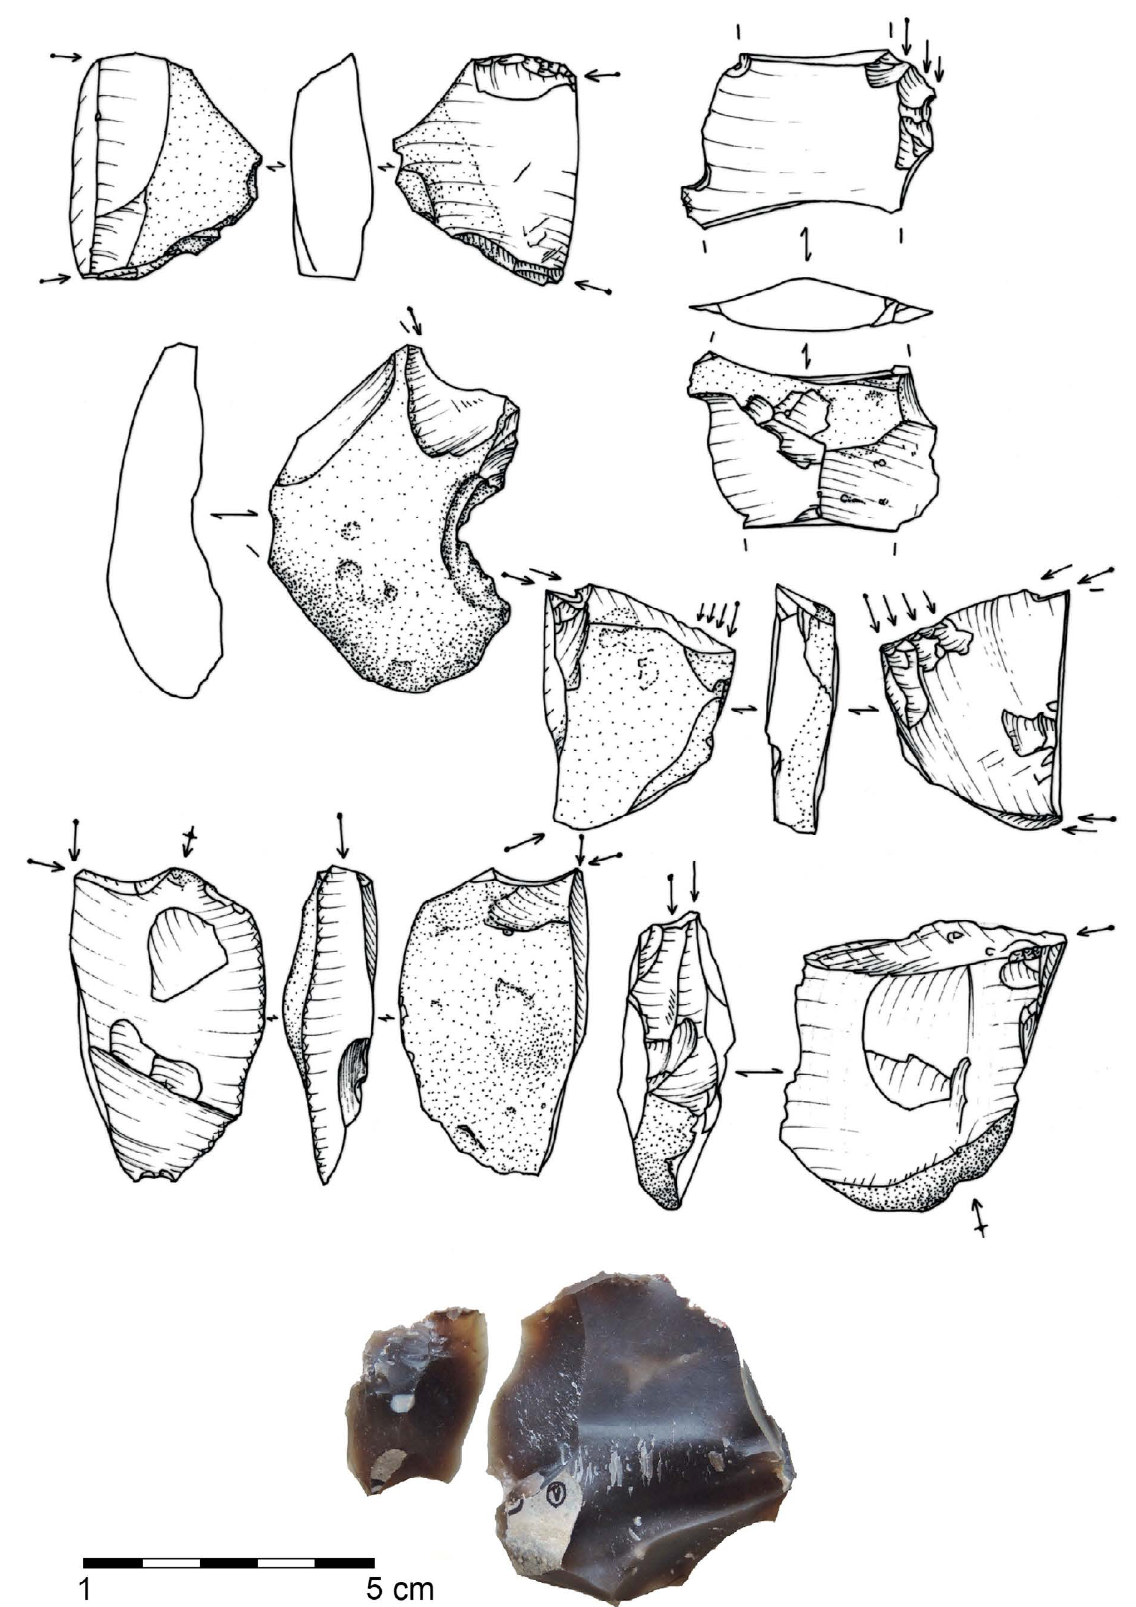
Figure 10. Burin décalé du site de d’Aubevoye « La Chartreuse » (Eure). Dessin de D. Prost et burin décalé expérimentale (M. Biard). Figure 10. Offset burin from Aubevoye site « La Chartreuse » (Eure). Drawing by D. Prost and experimental offset Journal of Lithic Studies (2017) vol. 4, nr. 2, p. xx-xx doi:10.2218/jls.v4i2.2540